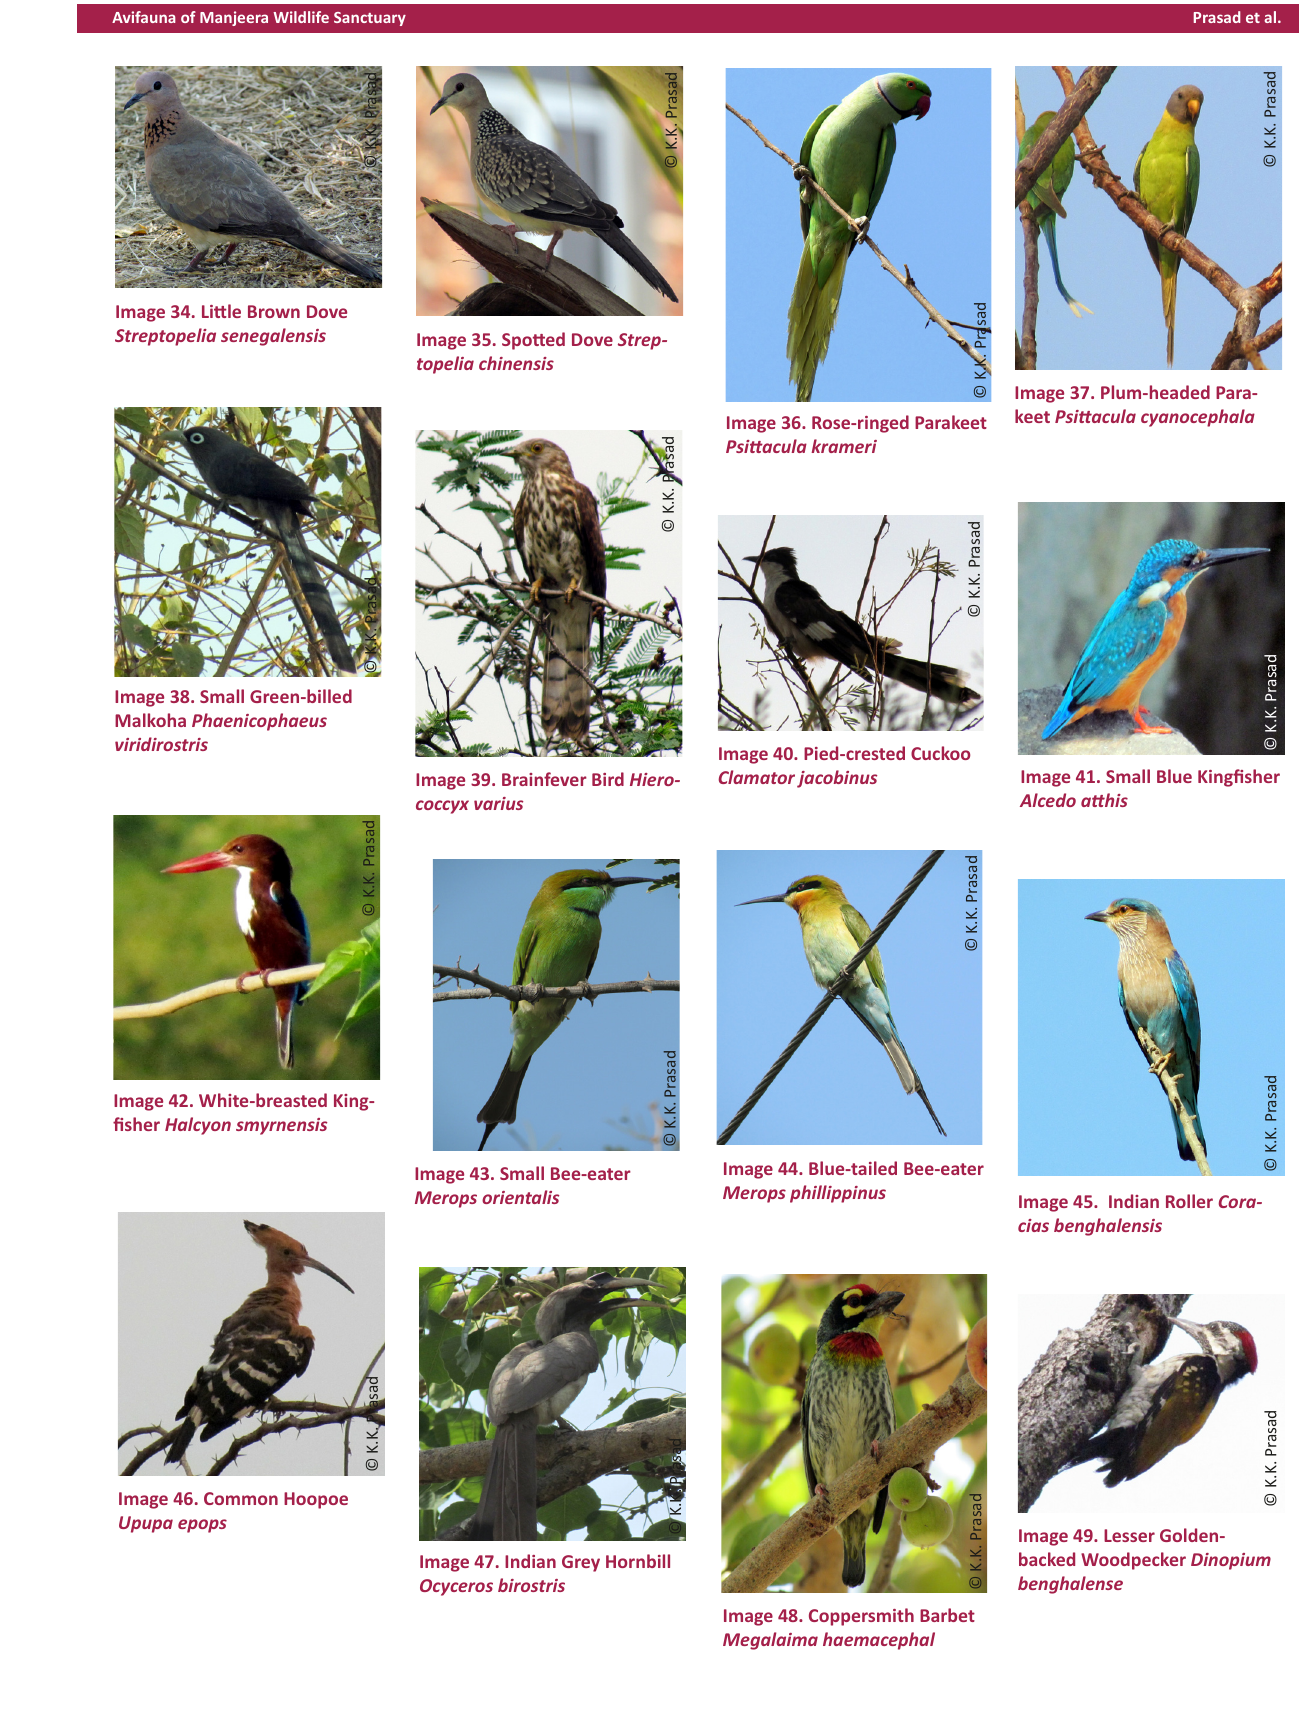
Image 48. Coppersmith Barbet Megalaima